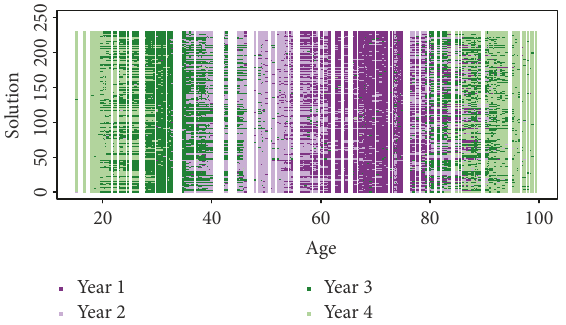
Figure 9: Consumption pattern for the 229 strategies identified on the Phase II Pareto front. The units are sorted based on their current ages with the coloring of each unit representing the time period in which the strategy assigns the unit to be used (dark purple = Year 1; light purple = Year 2; dark green = Year 3; light green = Year 4).